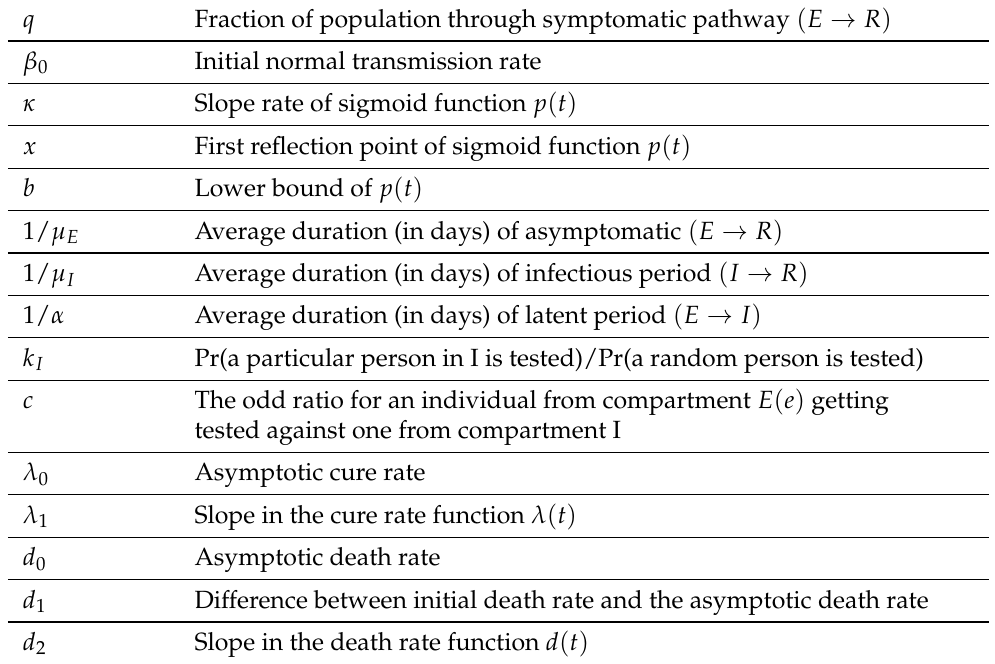
Table 1. Interpretation of Model